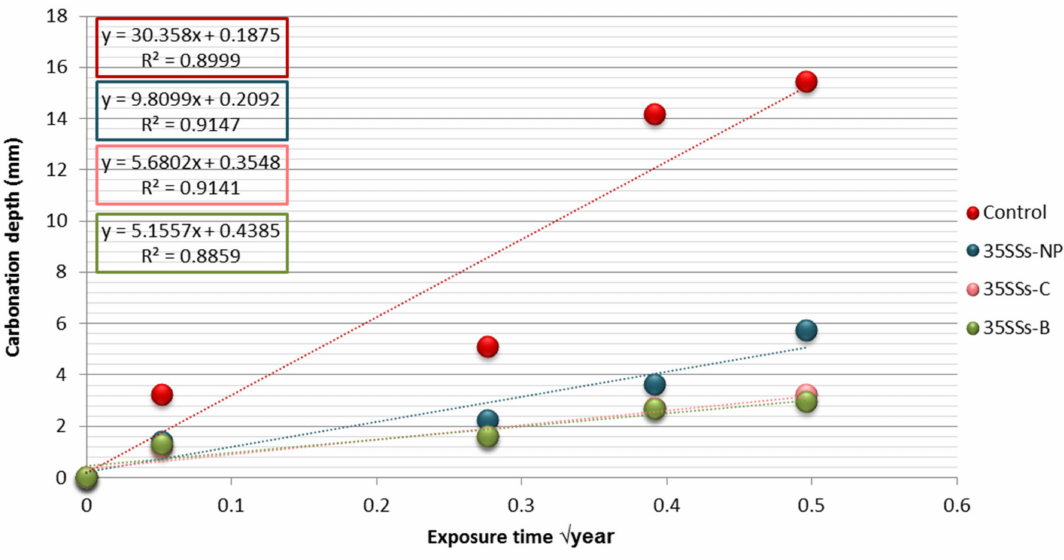
√ t of SCC control, 35SSS-NP, 35SSS-C, and